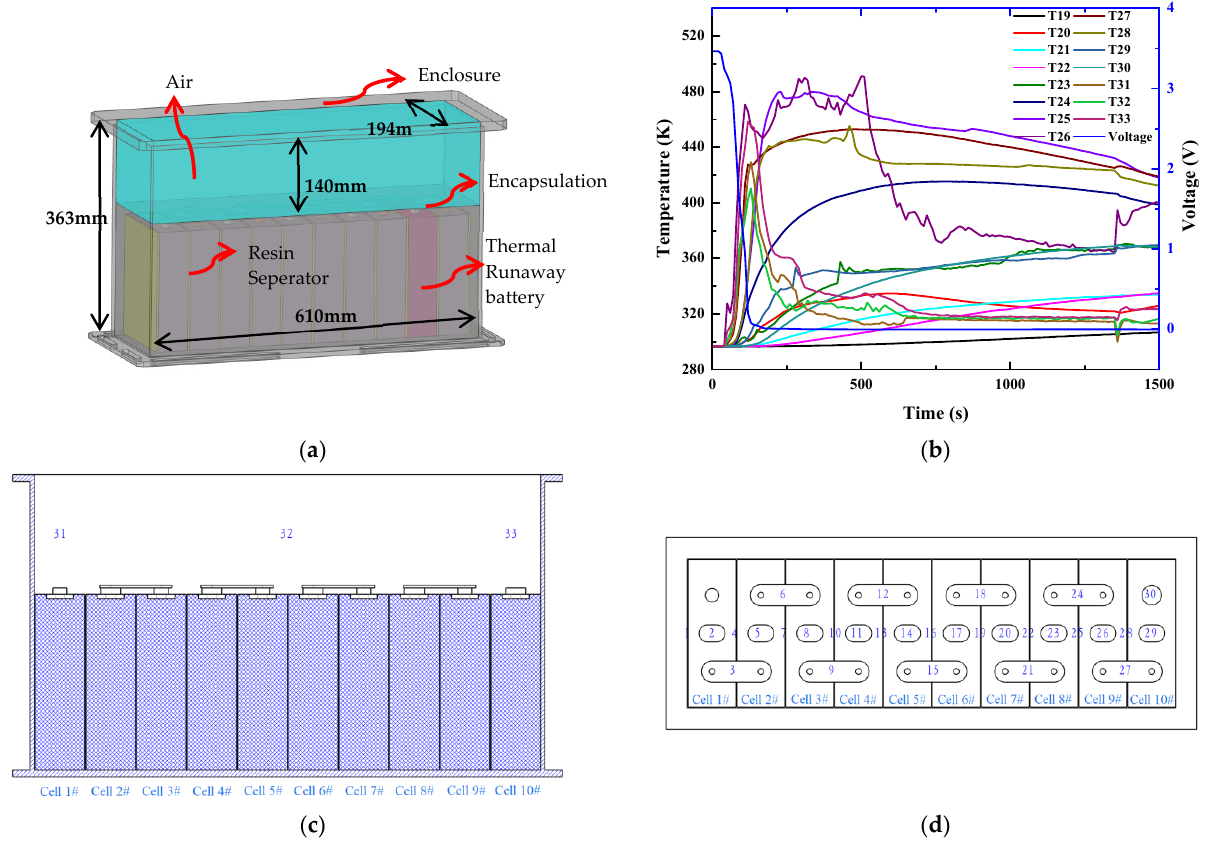
Figure 16. Large-scale LIB pack thermal runaway experiment: ( a ) Model of encapsulated cell pack in enclosure; ( b ) experimental measurement of temperature, voltage vs. time; ( c ) front view of battery pack sensor installation position; ( d ) top view of battery pack sensor installation position.